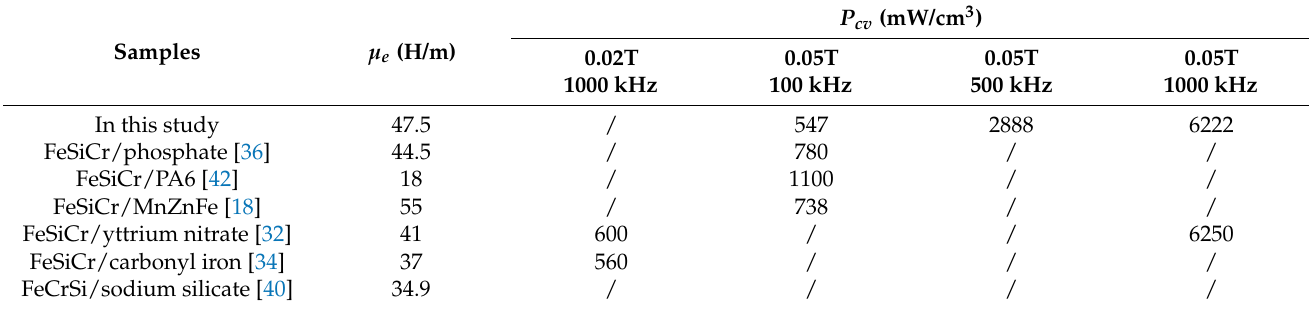
Table 2. Comparison of the magnetic performances in this study and the